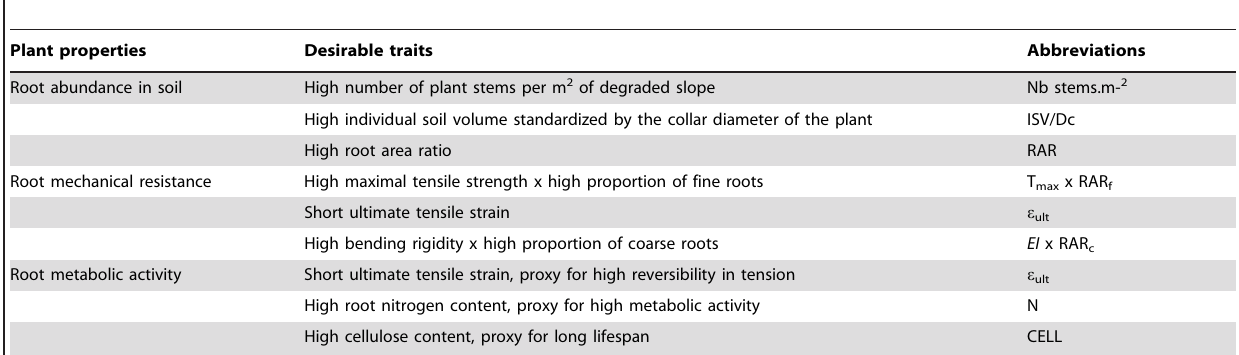
Table 1. Desirable traits to compare species efficiency for stabilizing slopes and abbreviations used in the text.